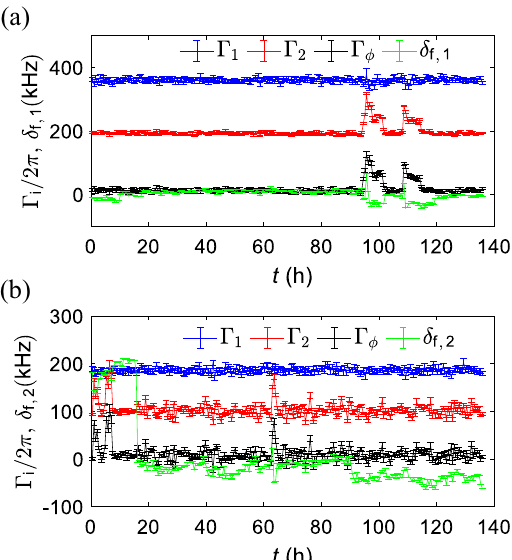
Fig. 6 Fluctuations of the qubit frequency and decay rates. a Fluctuations on the decay rates and the qubit frequency at ω 01,1 / (2 π ) = 5.51 GHz, over 136 h. b Fluctuations on the decay rates and the qubit frequency at ω 01,2 /(2 π ) = 5.39 GHz, over 136 h. In both panels, the error bars are two standard